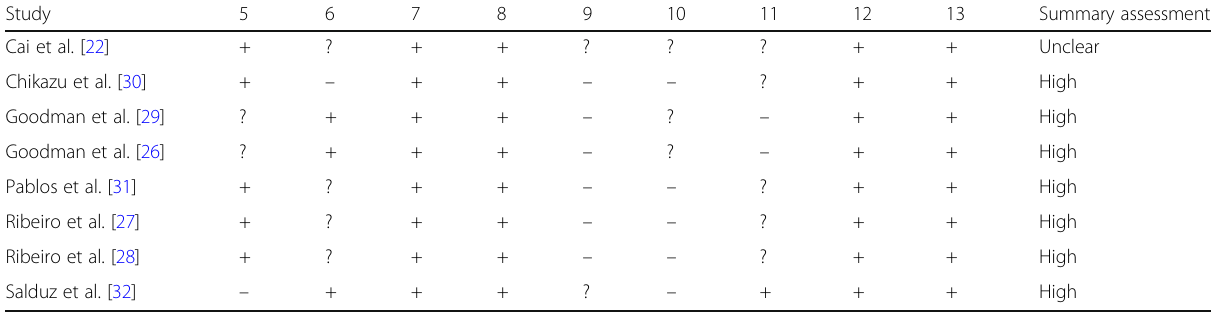
Table 4 Quality assessment of the methodology of the animal studies according to the items of the ARRIVE guidelines [18]